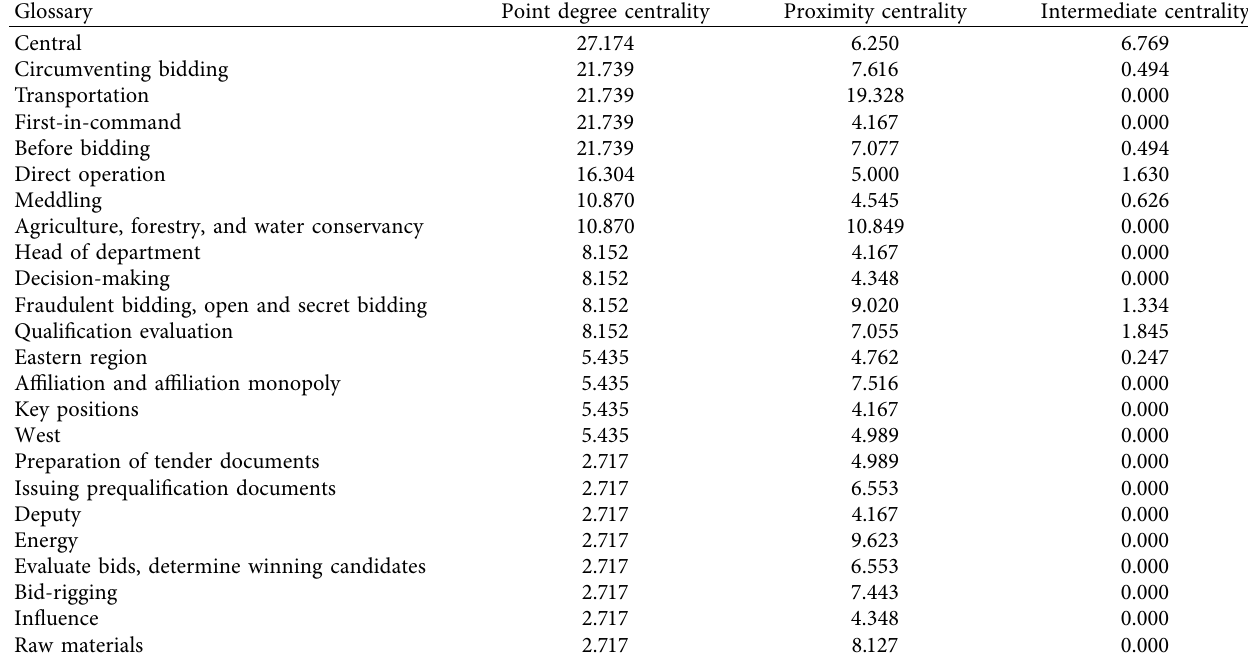
Table 2: Centrality of intervening collusion